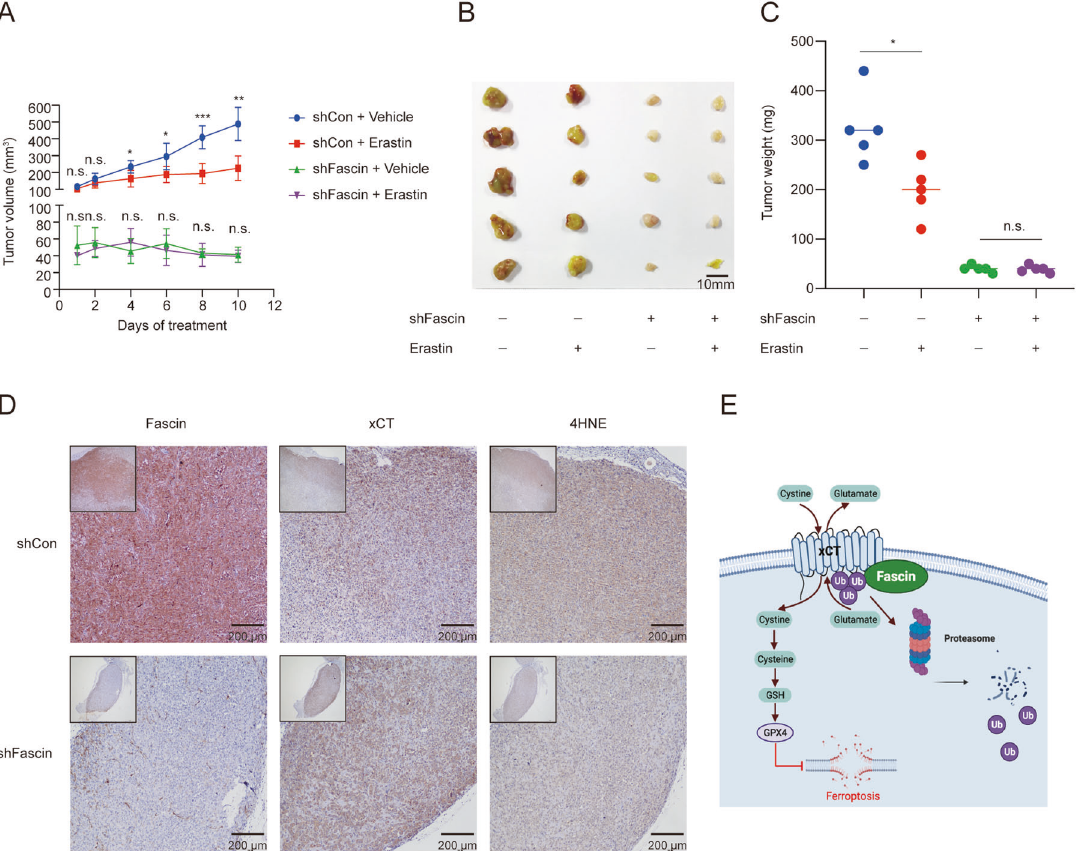
Fig. 6 Suppression of Fascin inhibits ferroptosis in vivo. Four-week-old immunode fi cient nude mice ( fi ve mice per group) were subcutaneously injected with the indicated MDAMB231 cells infected with control or Fascin shRNAs (1 × 10 6 cells per mouse) and treated with erastin (20 mg per kg intraperitoneal, twice every other day) at day seven. A Tumour growth curves. B Isolated subcutaneous tumours. C Tumour weight. D Representative images of IHC staining for Fascin, xCT, and 4HNE in the xenografts. E Schematic depicting the regulation of xCT by Fascin during ferroptosis. n.s. not signi fi cant. * p < 0.05, ** p < 0.01, and *** p < 0.001. The data are displayed as the means ±